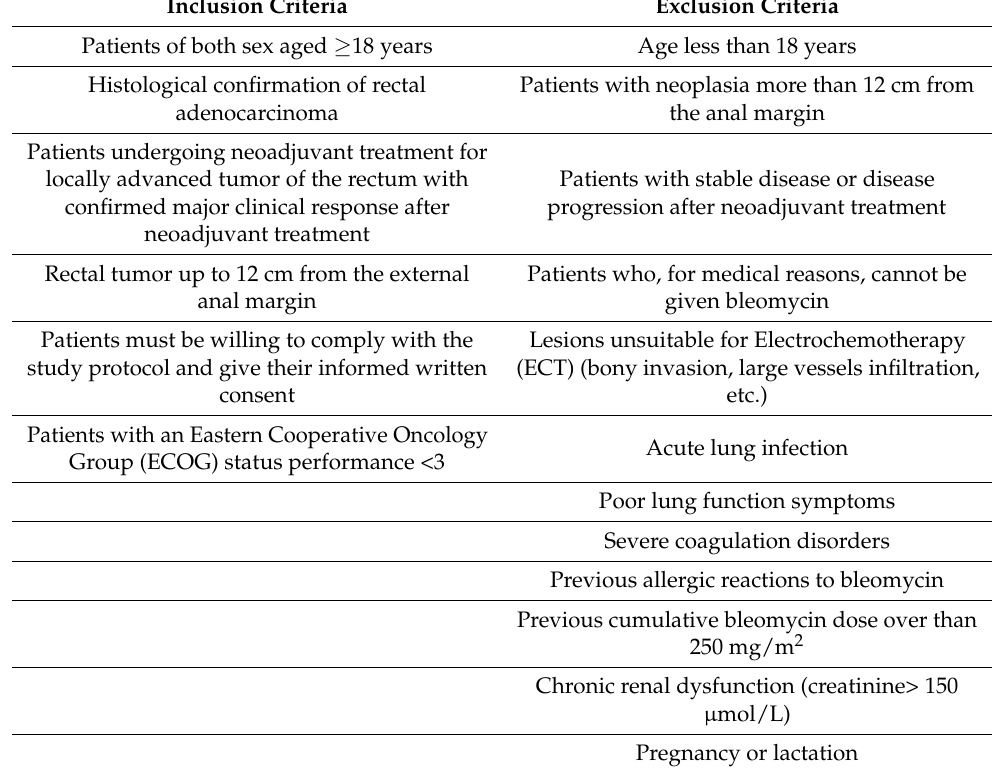
Table 1. Inclusion and Exclusion